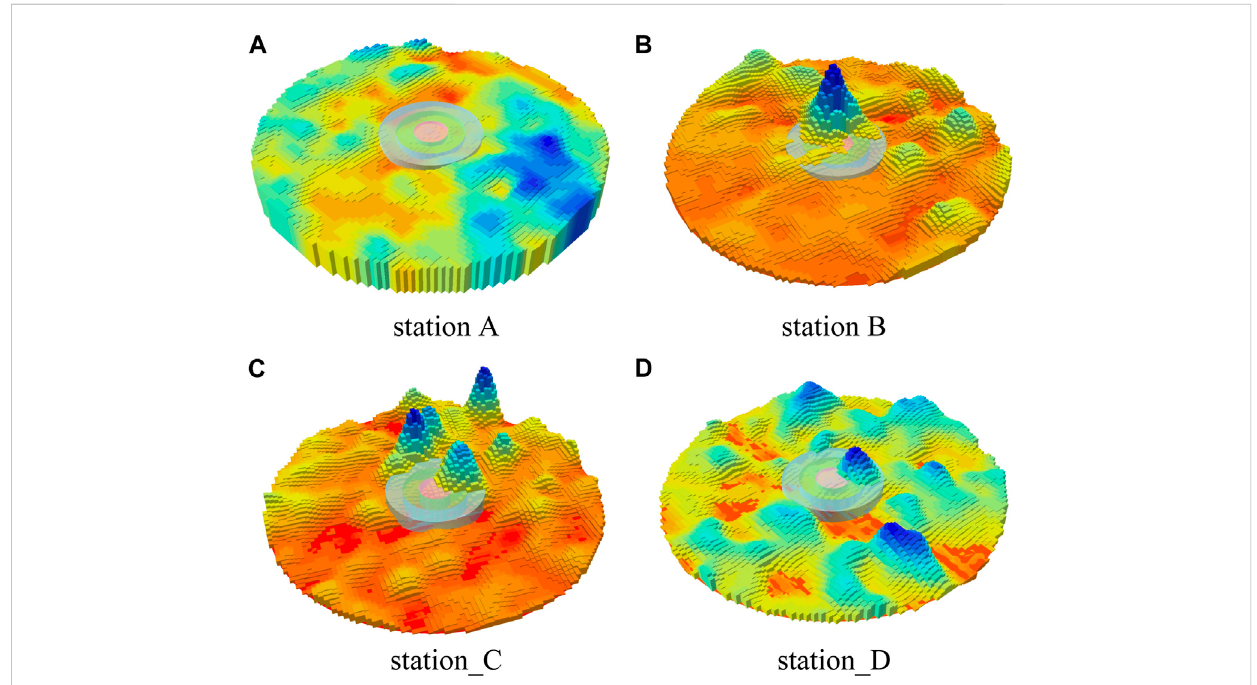
FIGURE 8 Topographywithina500 mradiusofstations. (A) StationA; (B) stationB; (C) stationC; (D) station (D) .Bluerepresentshigherelevationvaluesandred